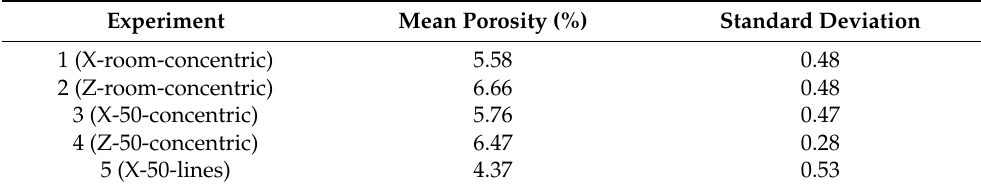
Table 2. Mean and standard deviation values of the porosity for experiments 1–5.